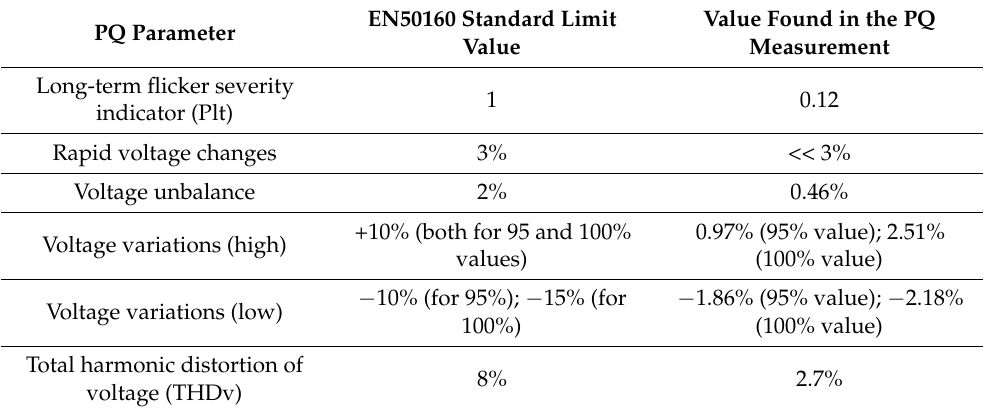
Table 5. PQ measurement results at a fast-charger terminal.